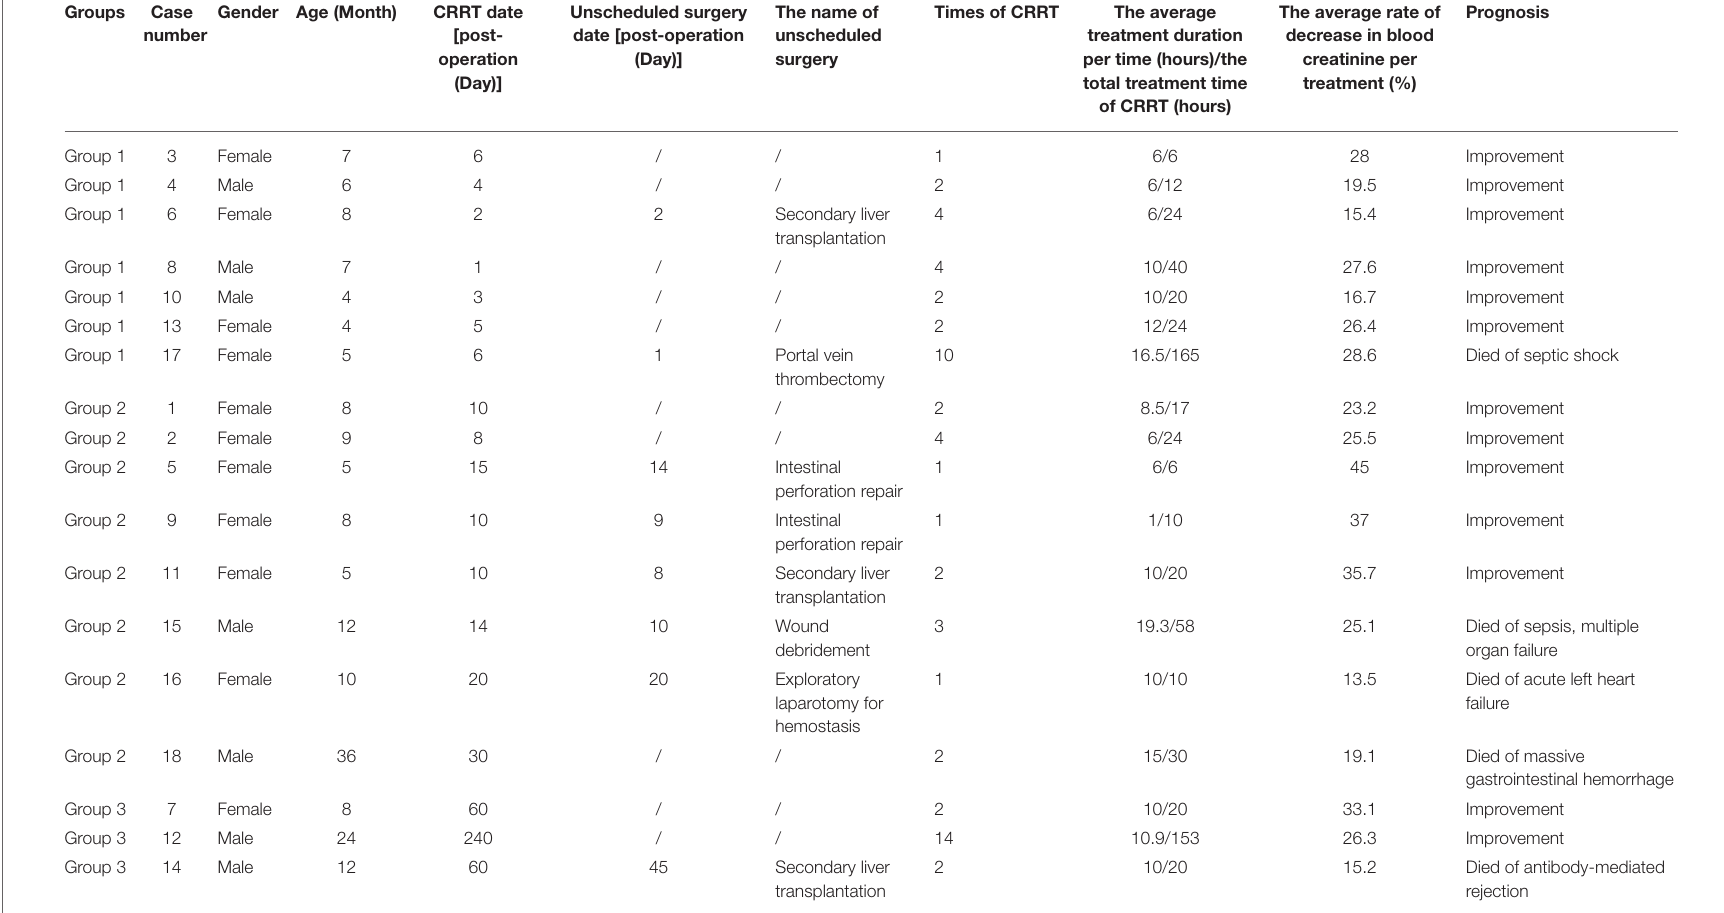
Group 1: with patients developed AKI directly (0-7 days) after primary liver transplantation. Group 2: with patients developed AKI later but < 30 days after primary transplantation. Group 3: with patients developed AKI later than 30 days after primary